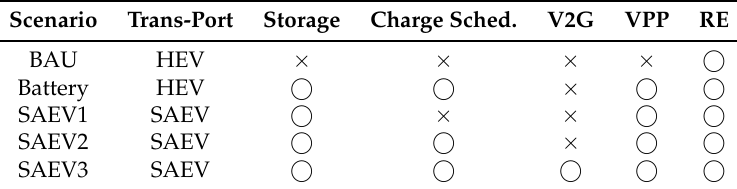
Table 5. Summary of scenarios. VPP does not apply to the microgrid case.